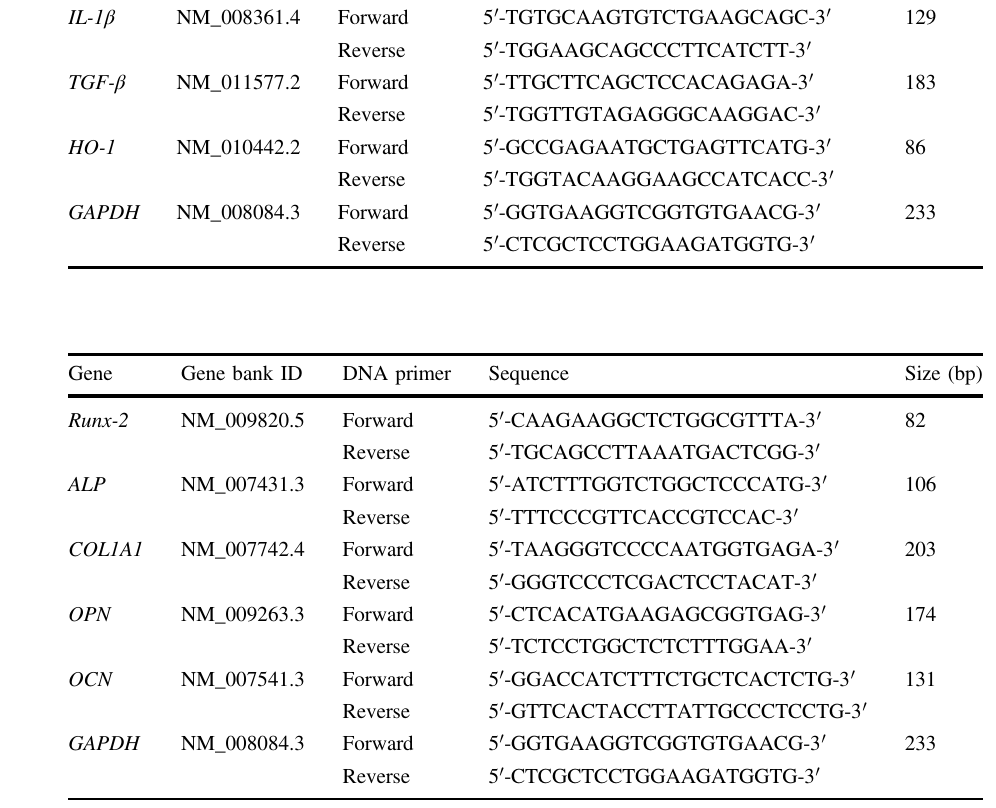
Table 1 Primers for pro- in fl ammatory (M1) and pro- regenerative (M2) marker